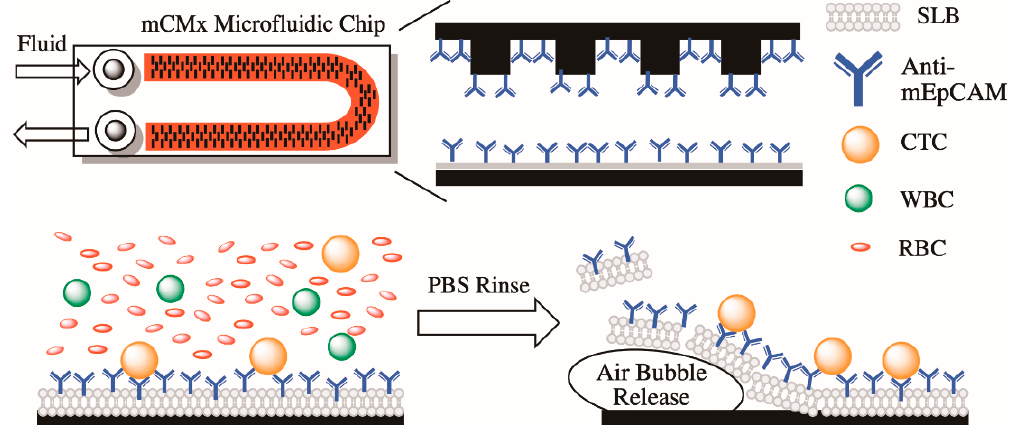
Figure 1. Schematic of the capture and subsequent recovery of circulating tumor cells with the mCMx system. Samples of 75 µ L of mouse blood were diluted to 450 µ L and injected into the microfluidic channel of the mCMx system. Circulating tumor cells (CTCs) bound to the binding sites of the anti-mEpCAM-conjugated, supported lipid bilayer (SLB) surfaces. After a phosphate buffered saline (PBS) rinse to remove non-specific binding cells, the CTCs remained adsorbed in the mCMx system. Subsequent purging with air foam disintegrated the SLB, thereby releasing the CTCs for further immunostaining or